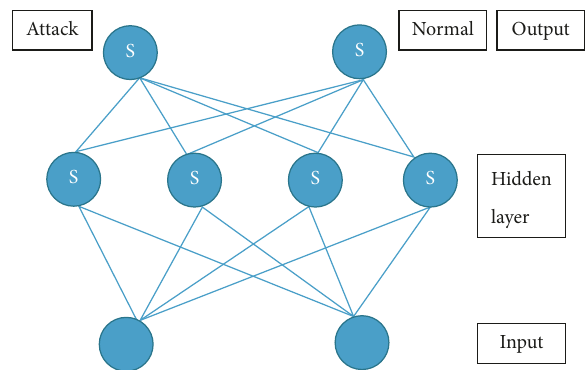
Figure 3: Representation of a perception with one hidden